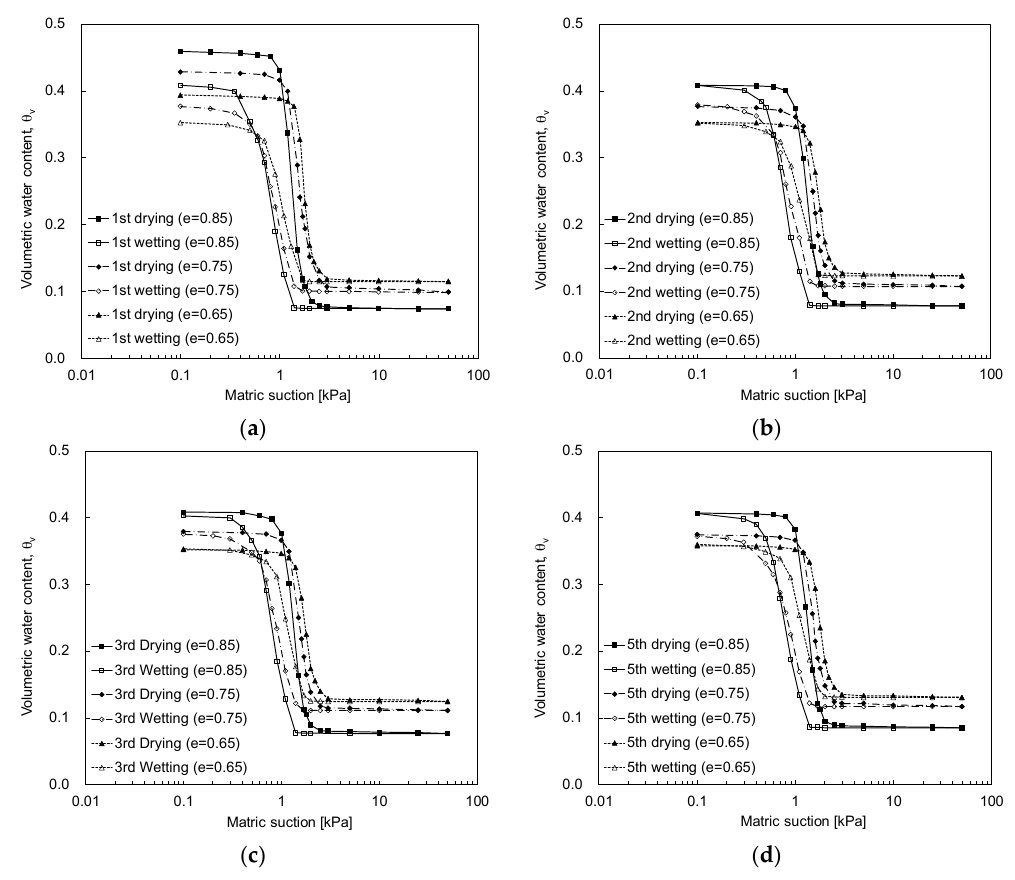
Figure 11. SWCC according to the initial void ratio: ( a ) first cycle; ( b ) second cycle; ( c ) third cycle; ( d ) fifth cycle. Table 3. Air entry values according to the initial void ratios.